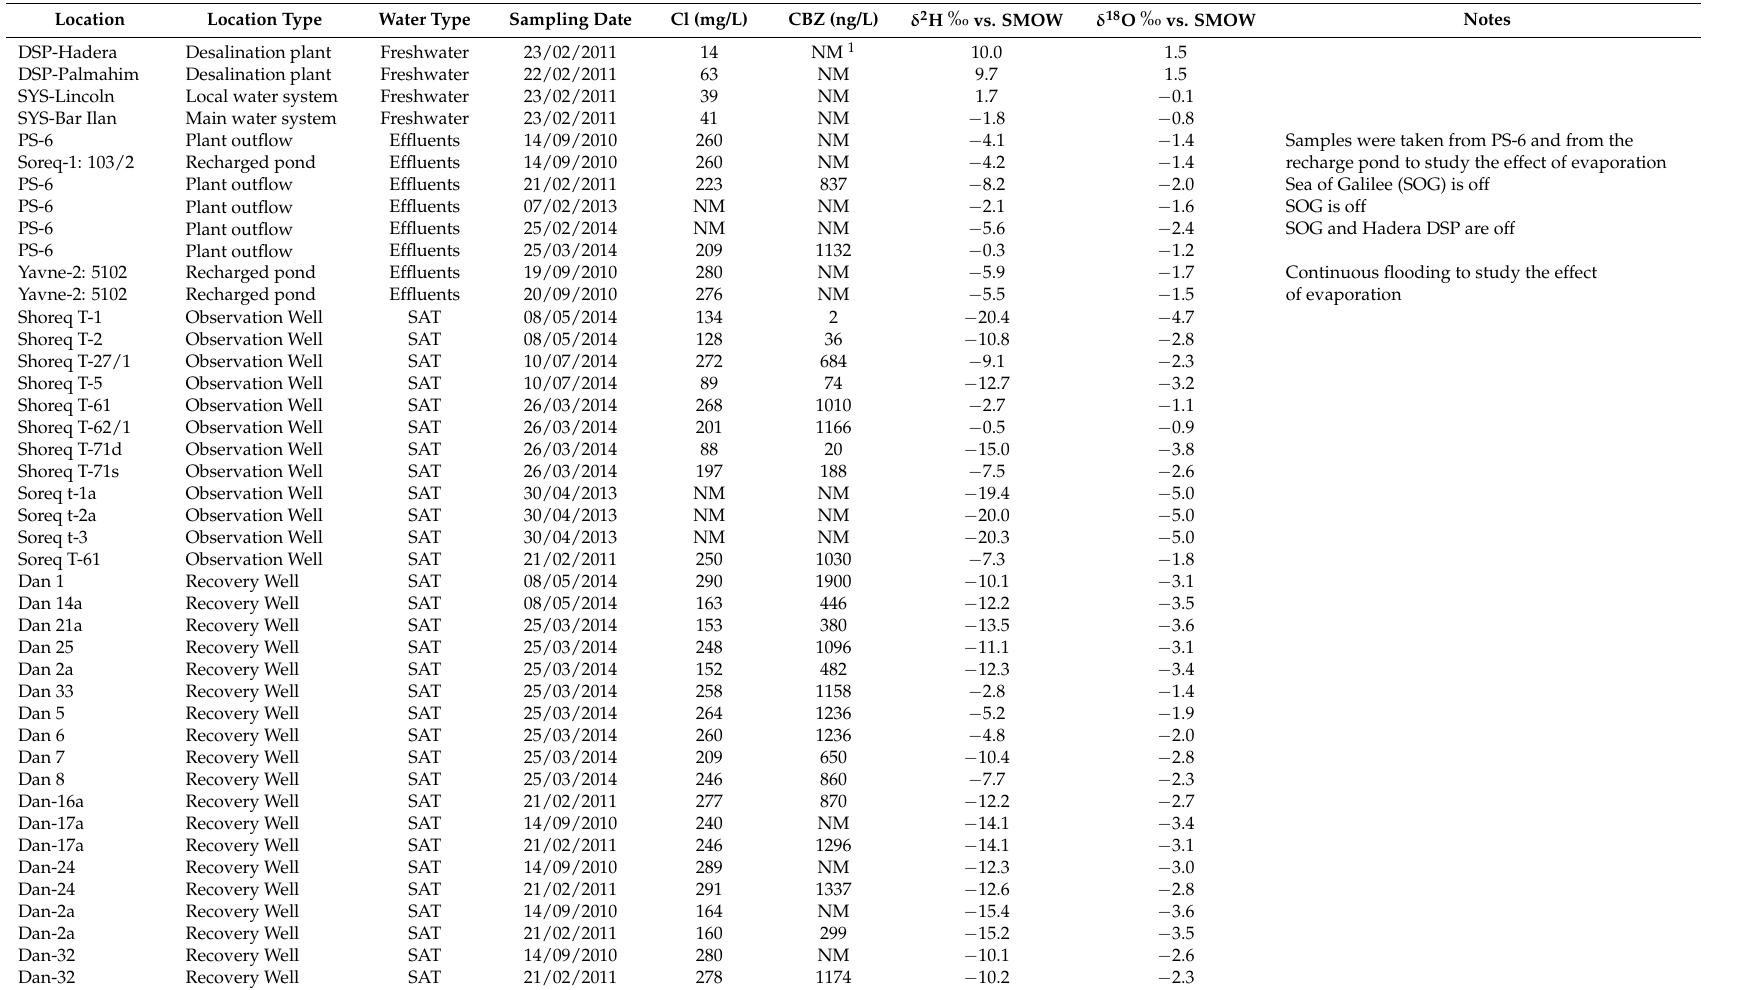
Table 2. Cl, CBZ and isotopic compositions of freshwater, effluent and recovered effluents in the